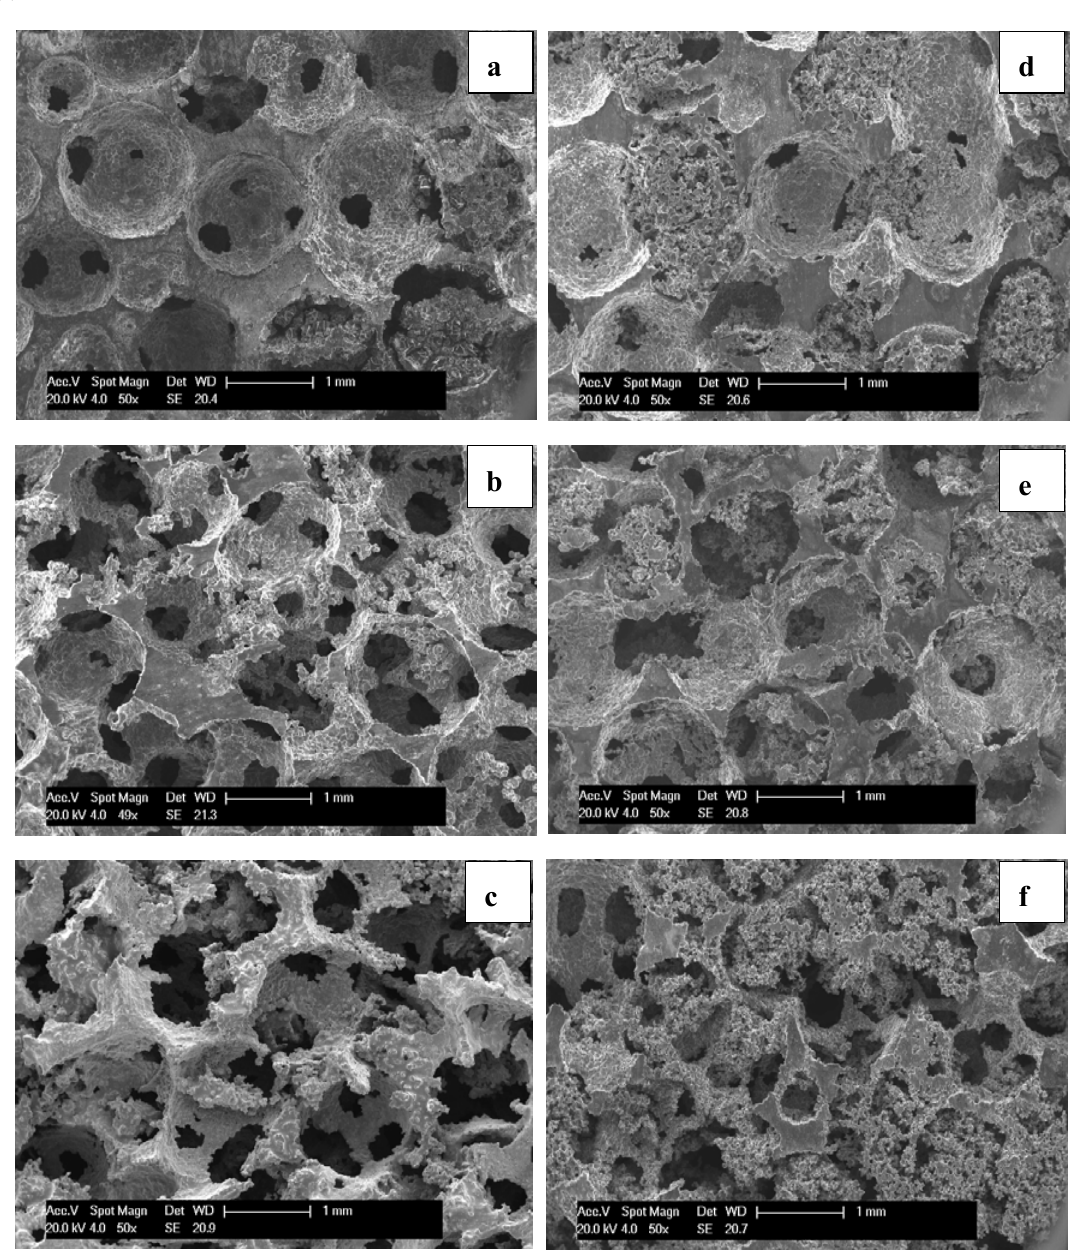
Figure 3. SEM images of infiltration in 1.4–2.0 mm bead preforms compacted at ( a ) 32 MPa; ( b ) 39 MPa; and ( c ) 50 MPa at 1 bar; and ( d ) 32 MPa; ( e ) 39 MPa and ( f ) 50 MPa at 2.5